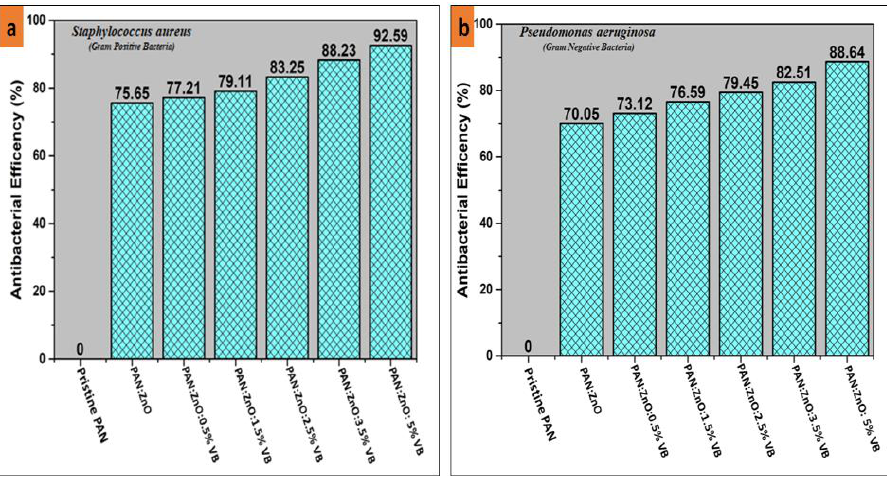
Figure 6. Antibacterial efficiency of pristine PAN electrospun nanofibers, ZnO/PAN electrospun nanofibers, 0.5% VB-loaded ZnO/PAN electrospun nanofibers, 1.5% VB-loaded ZnO/PAN electrospun nanofibers, 2.5% VB-loaded ZnO/PAN electrospun nanofibers, 3.5% VB-loaded ZnO/PAN electrospun nanofibers, and 5% VB-loaded ZnO/PAN electrospun nanofibers against ( a ) Staphylococcus aureus and ( b ) Pseudomonas aeruginosa .